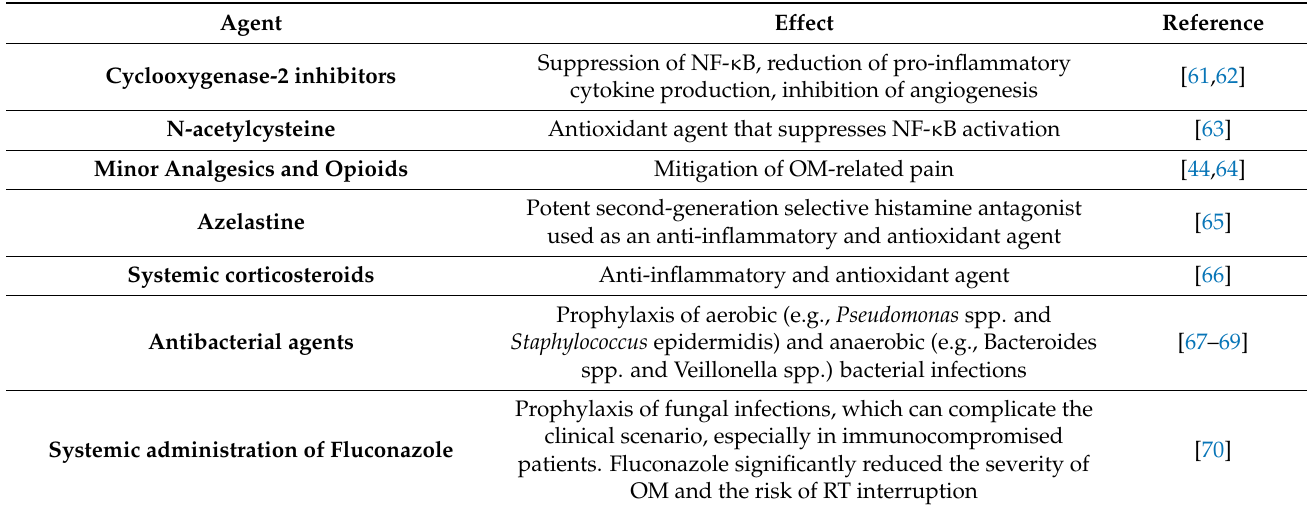
Table 2. Systematically applied agents for the treatment of OM listed from most to less commonly used.